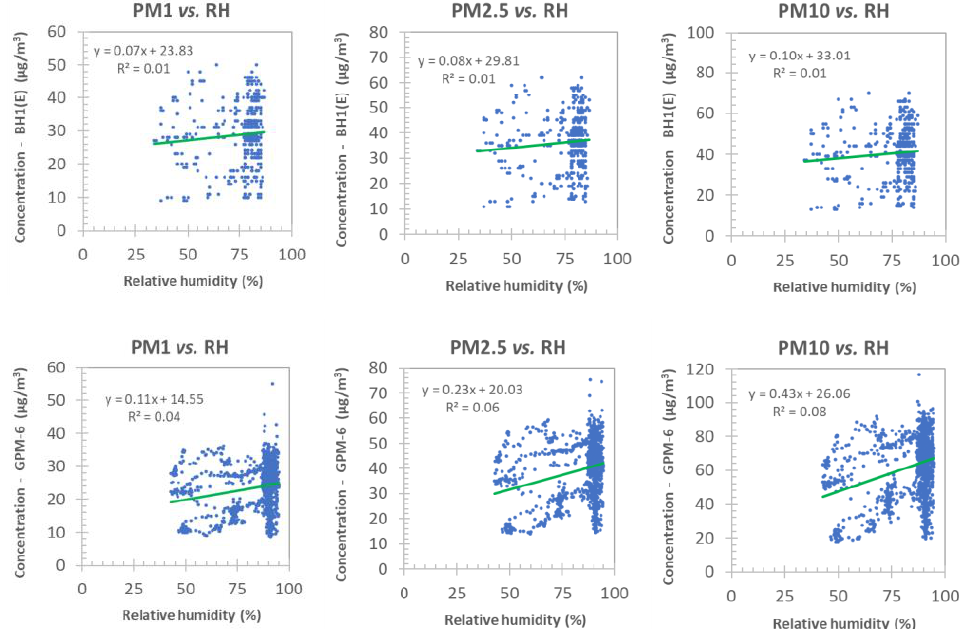
Figure 9. Effects of air relative humidity (RH) on PM x readings of BH1 (upper graphs) and GPM (lower graphs) sensors studied at the suburban site between 6 and 12 December 2021 (sampling rate: 1–5 min, n = 2018).